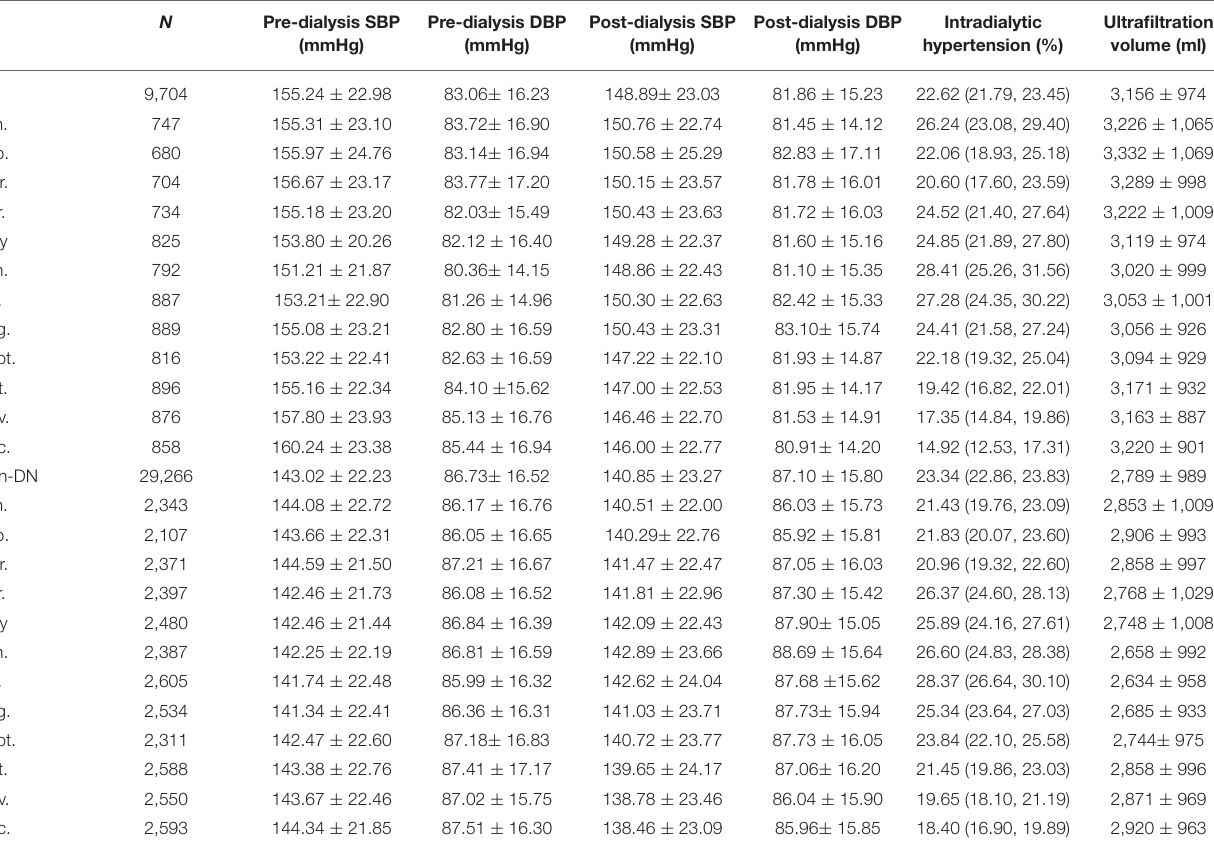
TABLE 3 | Pre-dialysis BP, post-dialysis BP, intradialytic hypertension, and HD UV in patients with DN and non-DN. N